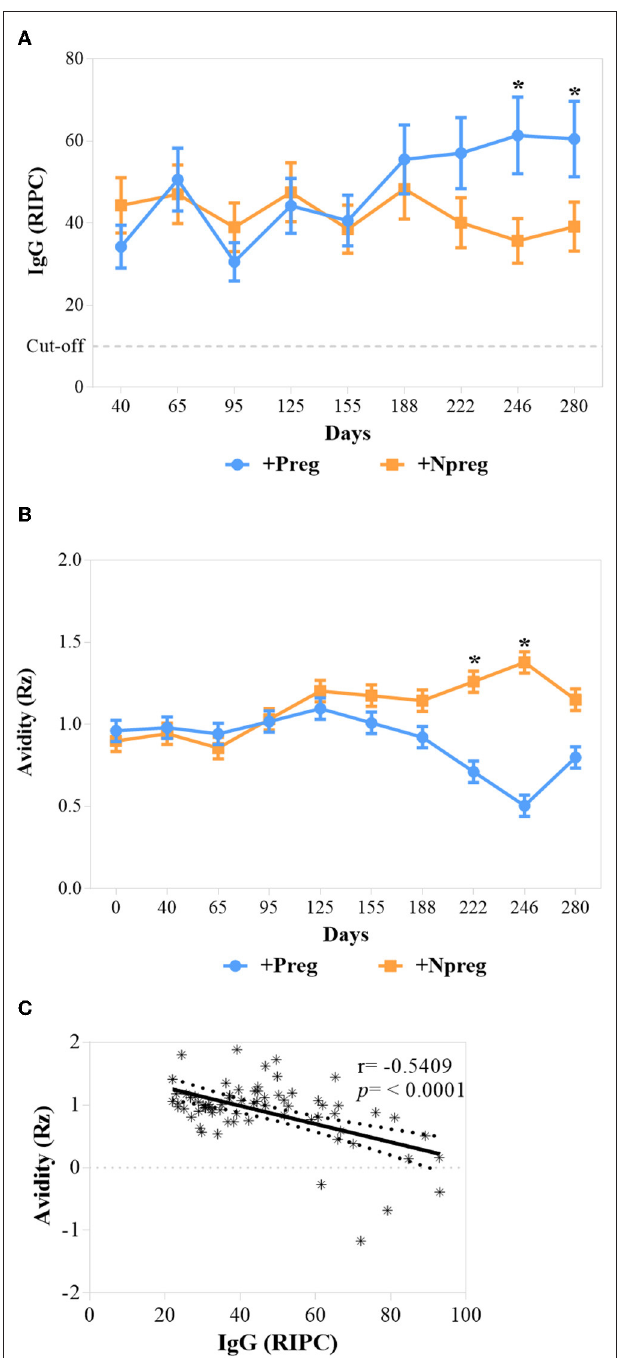
FIGURE 2 | The concentration of IgG, cutoff: ≥ 10 RIPC (A) , and Avidity values (Rz) (B) of IgG from sera of Neospora caninum infected cows. Each point represents the mean ± standard error of the mean (SEM) at the different sampling times for groups + Preg and + Npreg. Correlations between Avidity (Rz) and RIPC for + Preg group (C) . The significant statistical differences between groups were analyzed: * p <